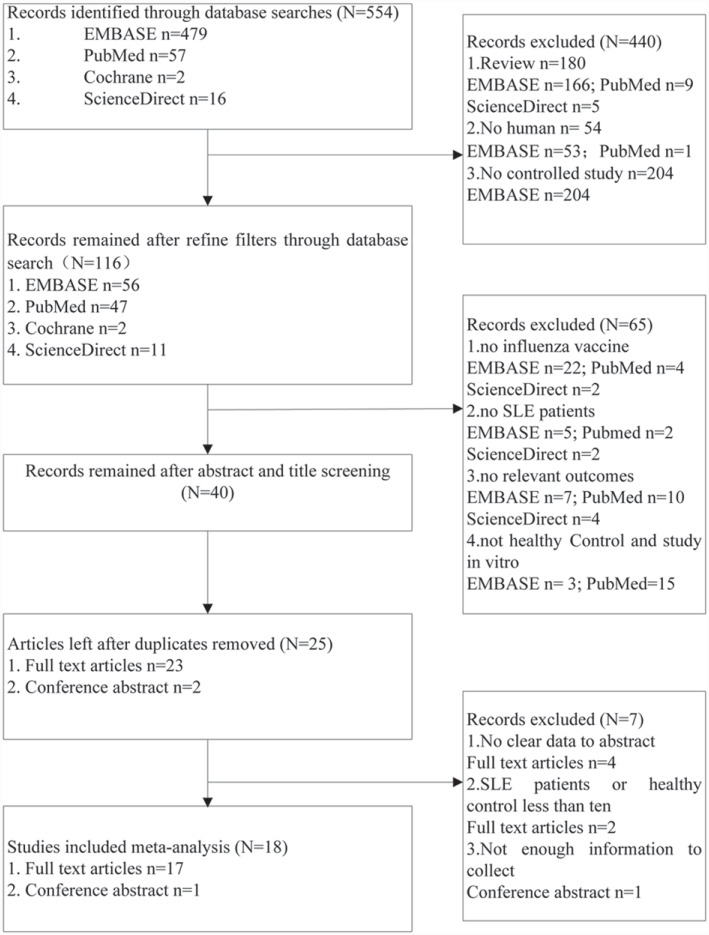
Flow Chart of Study Selection.